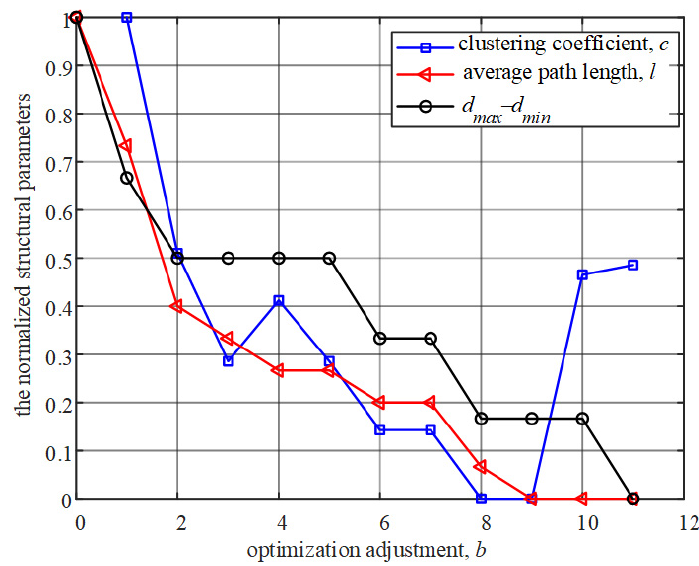
Figure 3. Normalized topology parameters.